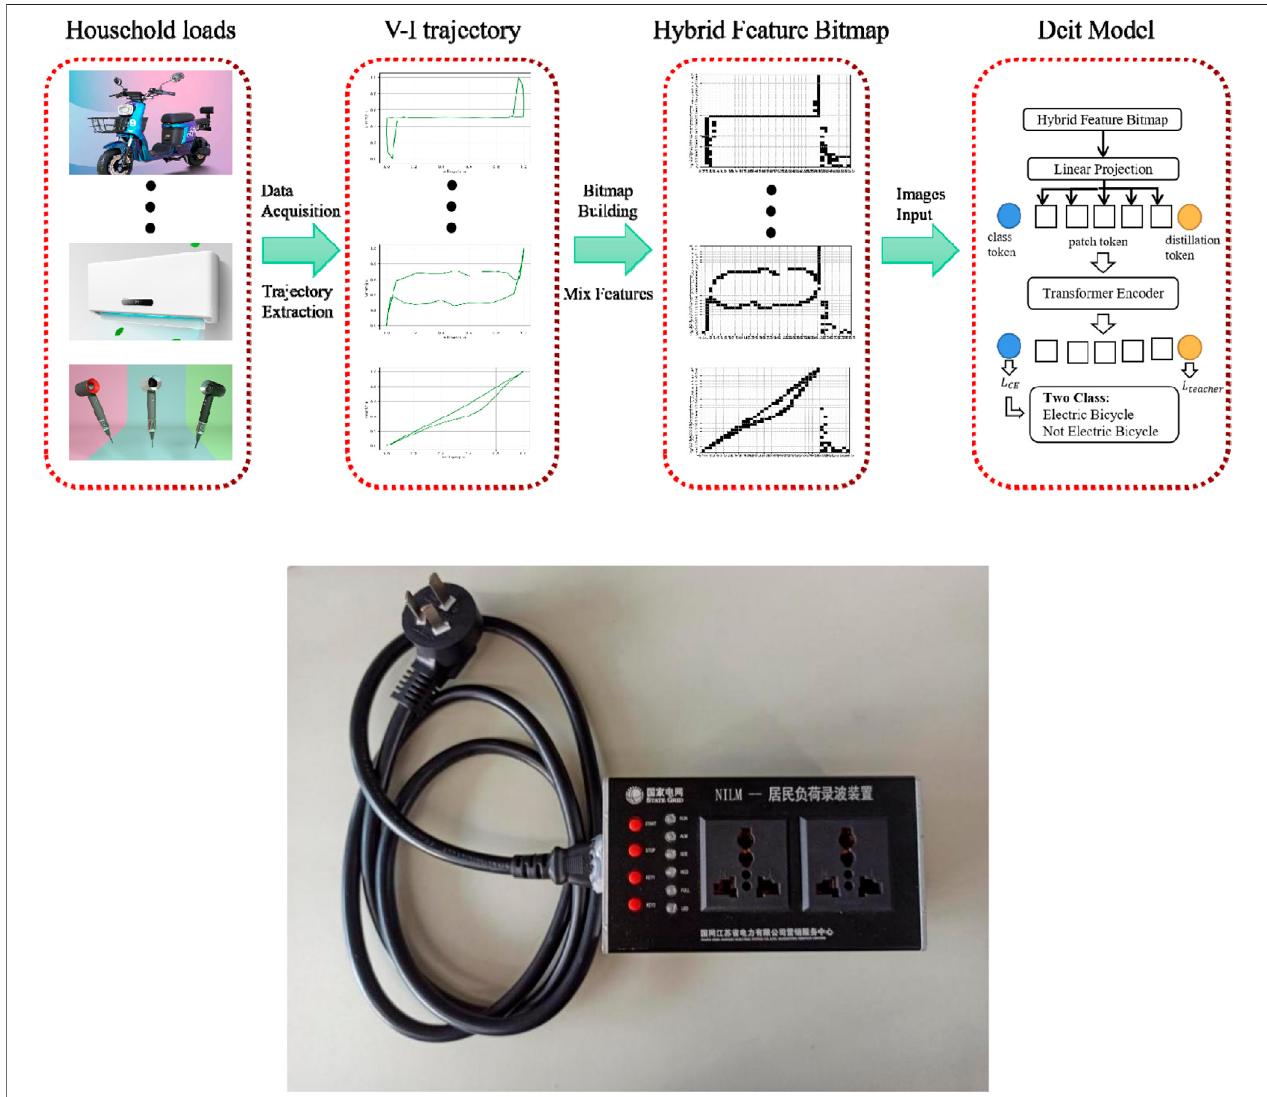
FIGURE 9 | Overall fl ow chart of this method. The physical picture of the data acquiring device.